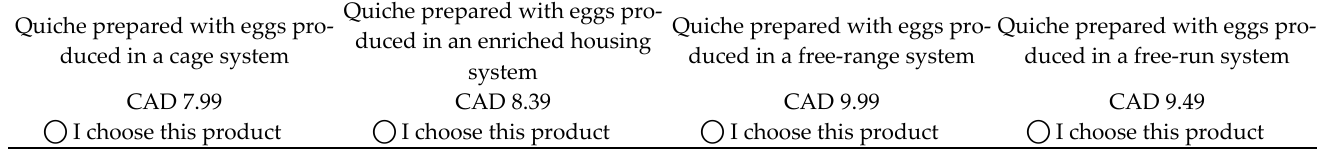
Figure 1. Choice set used in the online questionnaire for